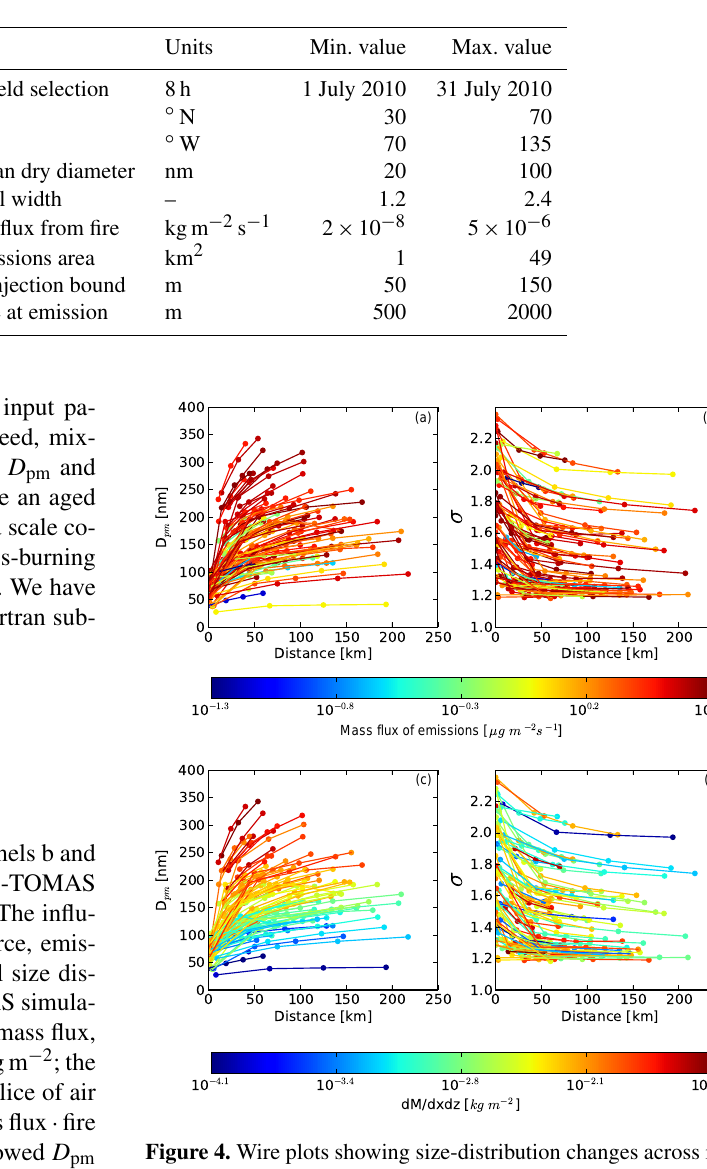
the 1.32 modal-width asymptote in the limit of infinite coag- ulation found by Lee (1983), the SAM-TOMAS simulations converge to a limit of 1.2–1.25. This is likely due to the size- distribution bin spacing in the SAM-TOMAS model, where modal widths < 1.32 are smaller than a single TOMAS size bin width, which results in less accurate fits of σ for smaller σ values. Figure 5 is a scatterplot of σ vs. D pm for each point seen in Fig. 4, excepting those at distances less than 25 km (points close to the emissions source have been removed). The points are colored by d M/ d x d z . Thus, Fig. 5 shows the results